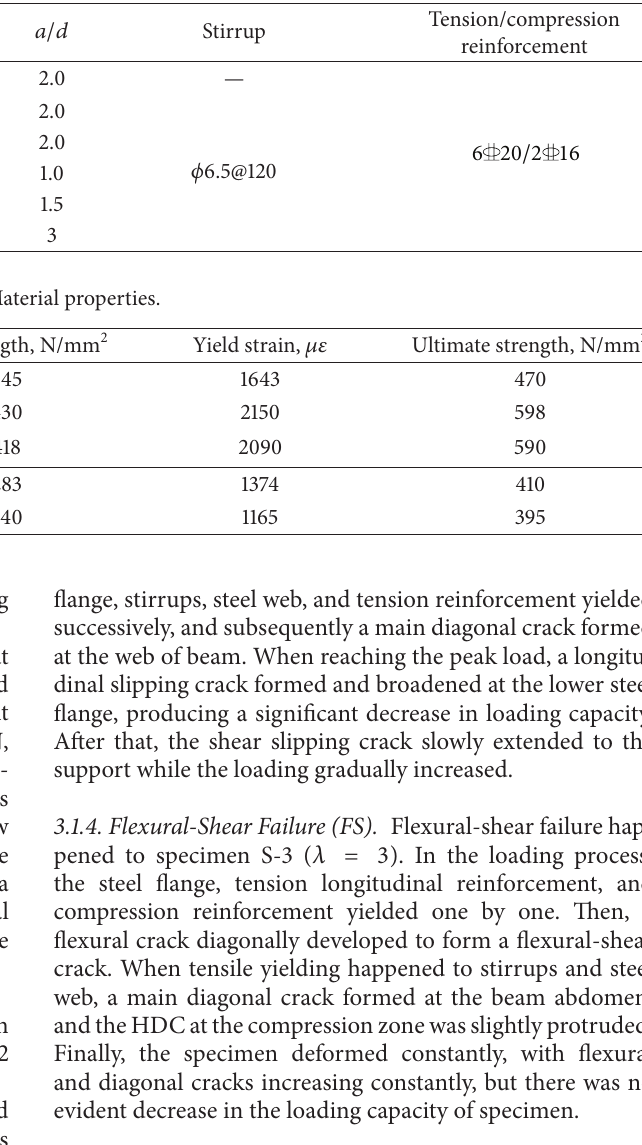
Table 2: Parameters of specimens.